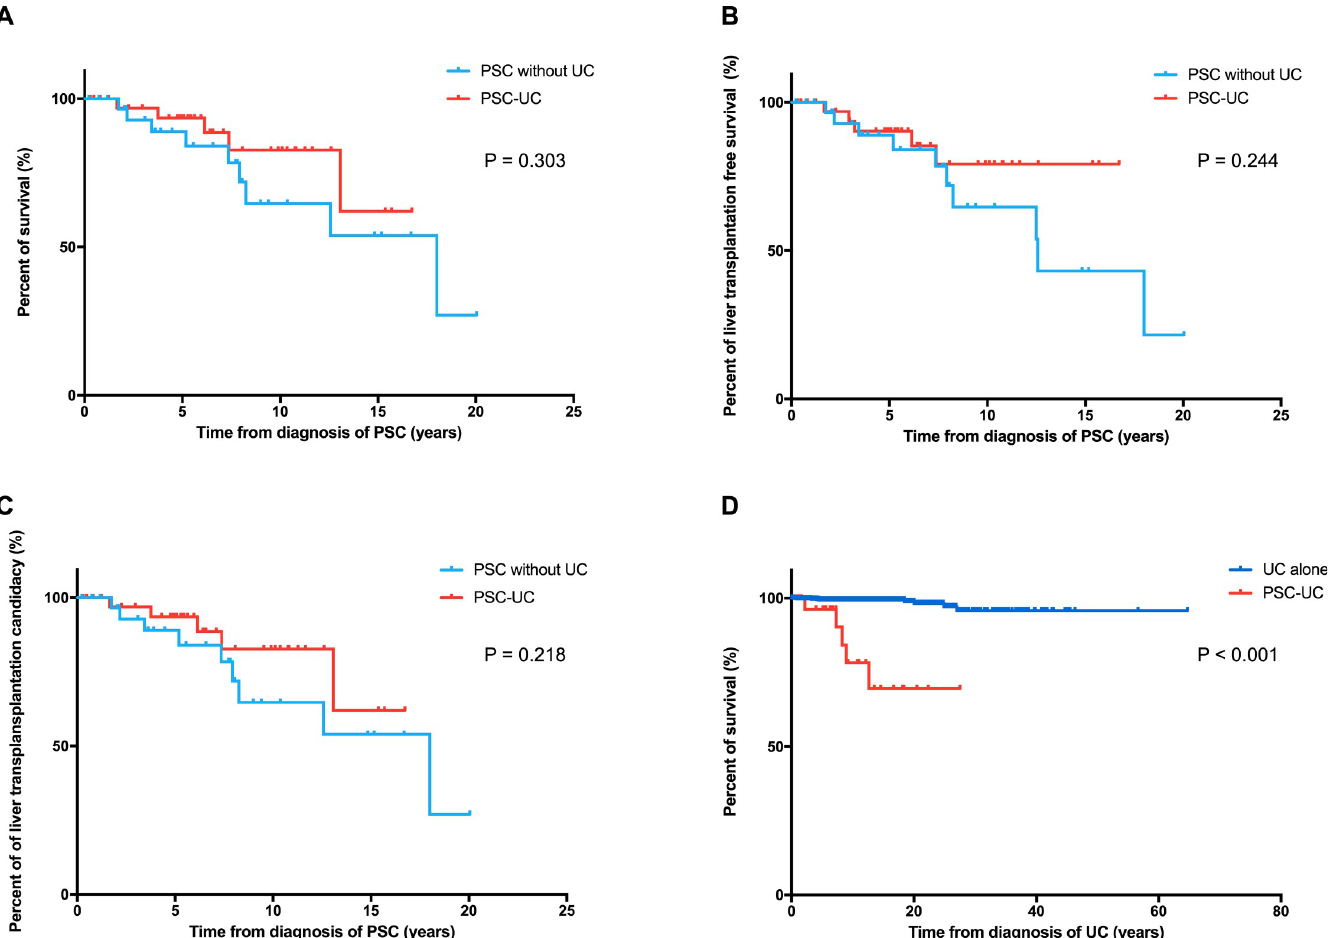
Fig 3. Kaplan-Meier curves of survival (A), liver transplantation free survival (B), time to liver transplantation candidacy (C) from PSC diagnosis, and survival from UC diagnosis (D).